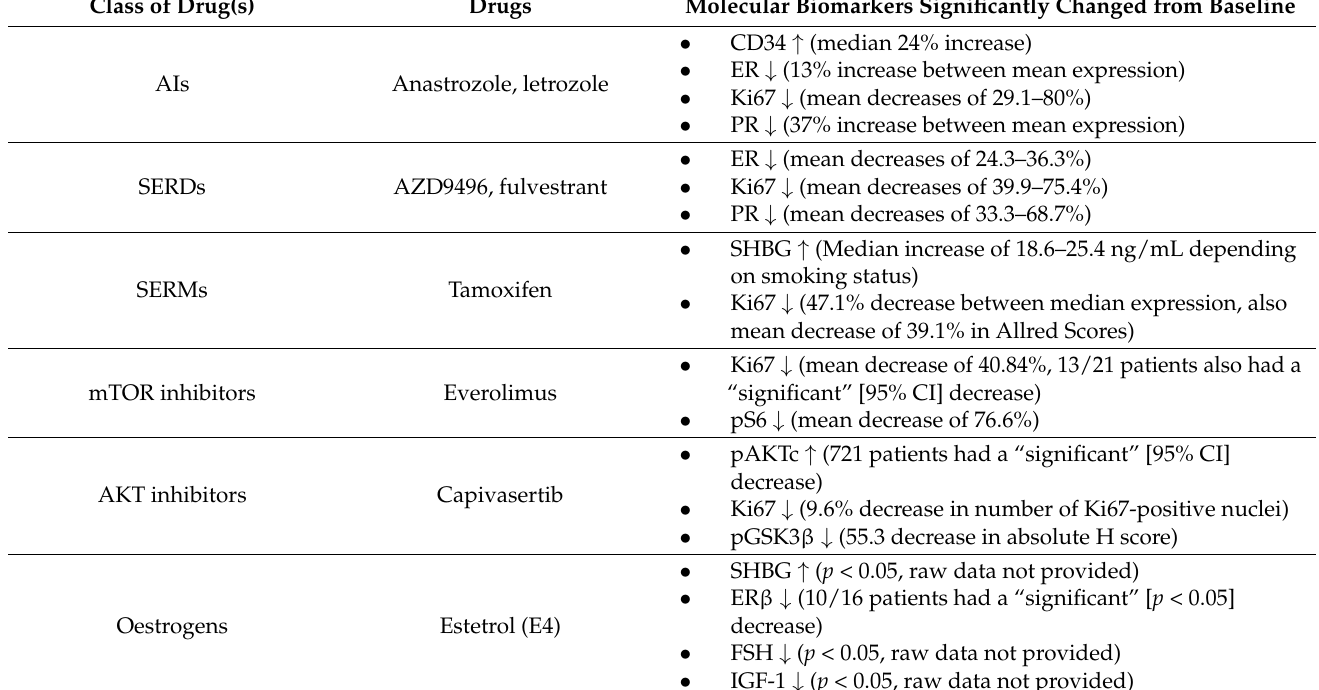
Table 2. Summary table of statistically significant (<0.05) biomarker changes associated with each class of drug given in WoO study. Raw data recorded where available to reflect the variability in assessing changes in